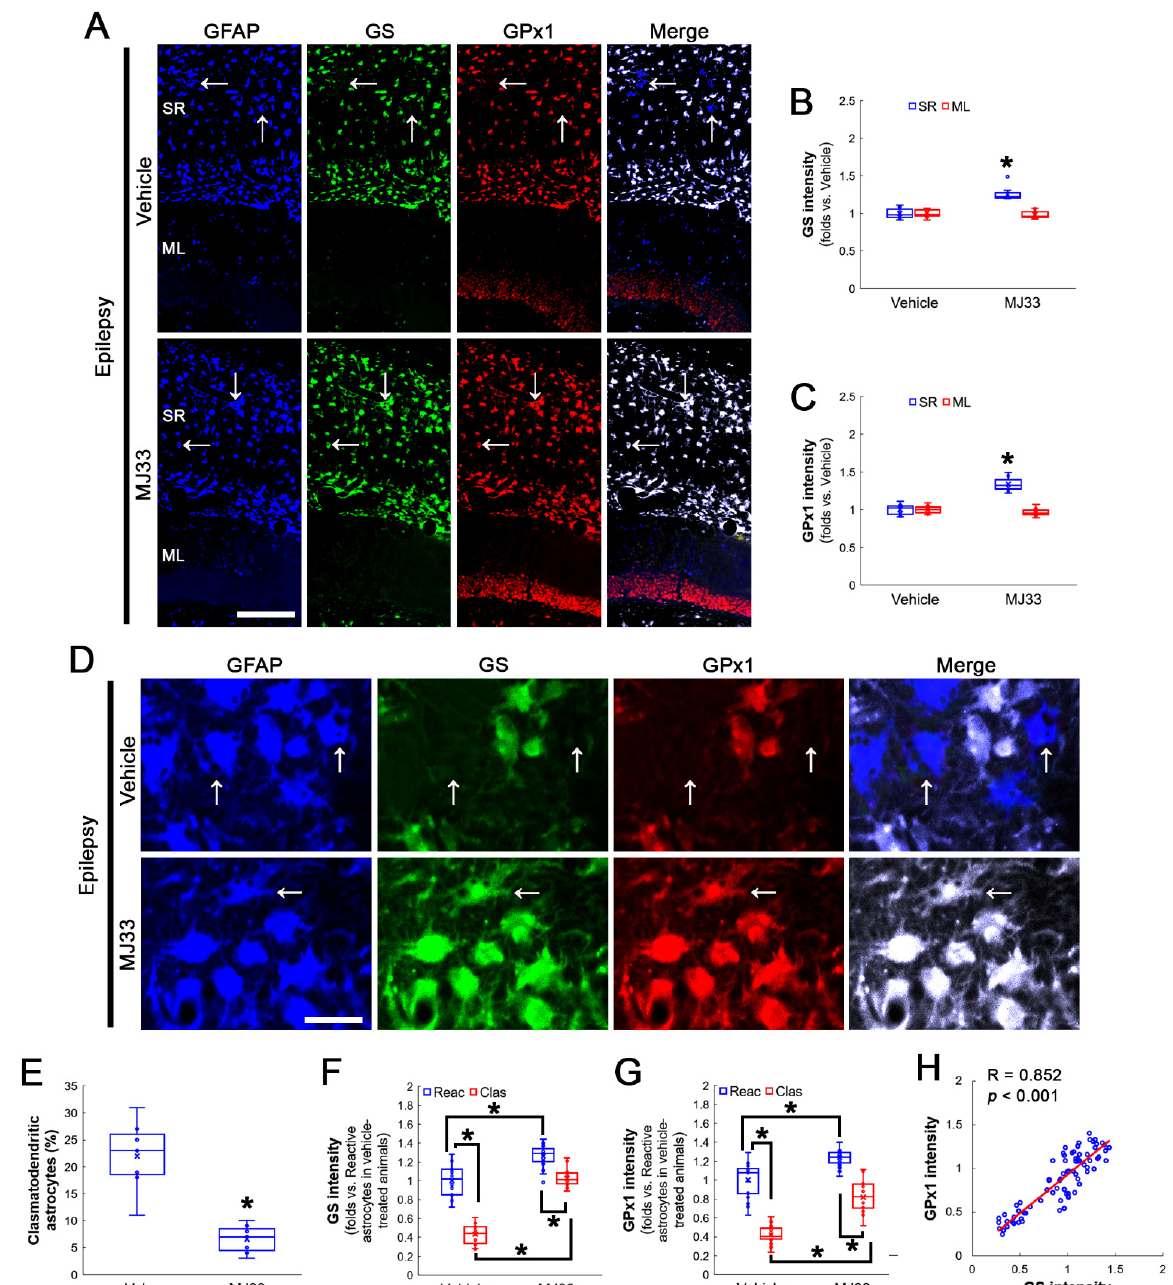
Figure 5. Effects of MJ33 on GS and GPx1 expressions and clasmatodendritic degeneration of CA1 astrocytes in chronic epilepsy rats. As compared to a vehicle, MJ33 upregulates both GS and GPx1 expression in reactive astrocytes and clasmatodendritic (vacuolized) astrocytes (arrows) within the stratum radiatum (SR) of the CA1 region. NAC also ameliorates clasmatodendritic degeneration. MJ33 does not change GS and GPx1 expressions in the molecular layer (ML) of the dentate gyrus. ( A ) Representative photos of GFAP, GS and GPx1 expression in the hippocampus. Bar = 250 μ m. ( B , C ) Quantification of GS ( B ) and GPx1 ( C ) intensity in the SR and the ML following MJ33 treat- ment ( * p < 0.05 vs. control animals; Mann–Whitney test; n = 7 rats, respectively). ( D ) Representative photos of triple fluorescent staining of GFAP, GS and Prdx6 expression in CA1 astrocytes of chronic